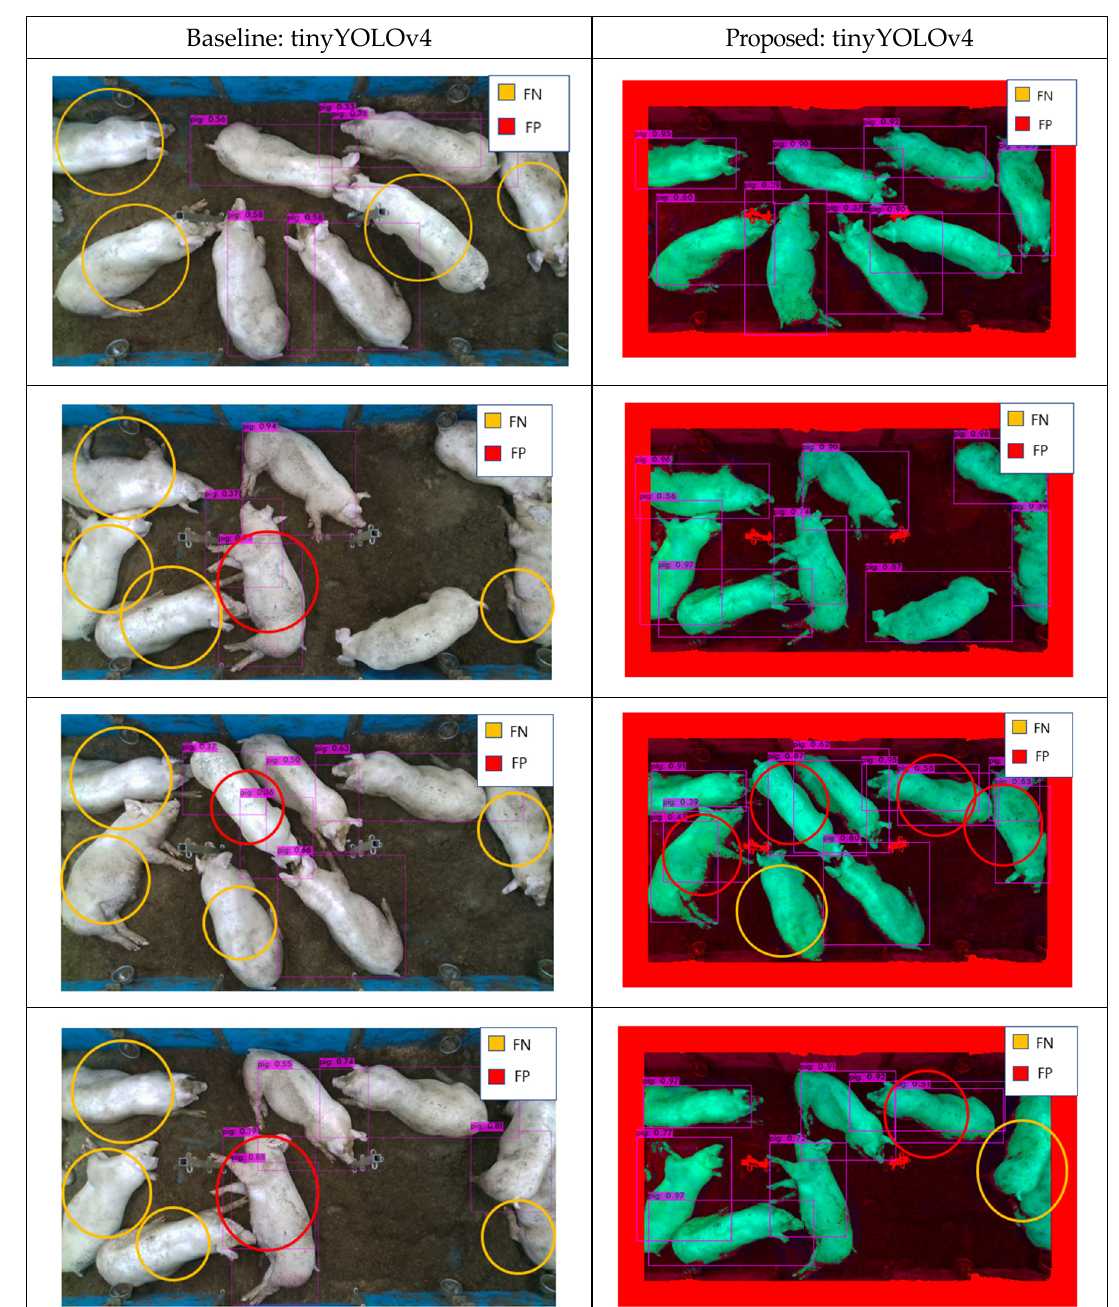
Figure 15. Detection results for Chungbuk with object detectors [41] (Baseline vs. Proposed) that shows solved cases and unsolved cases.